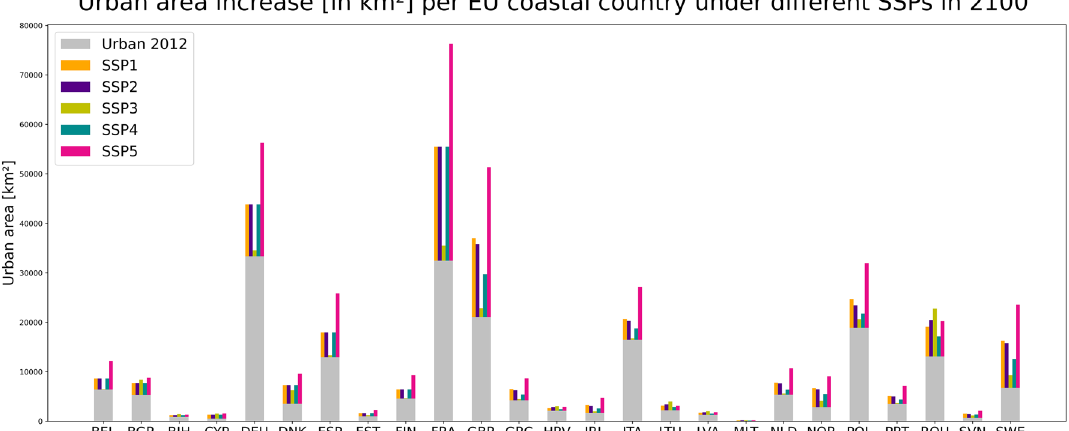
Figure 2. Urban extent [km 2 ] per EU coastal country under different SSPs in